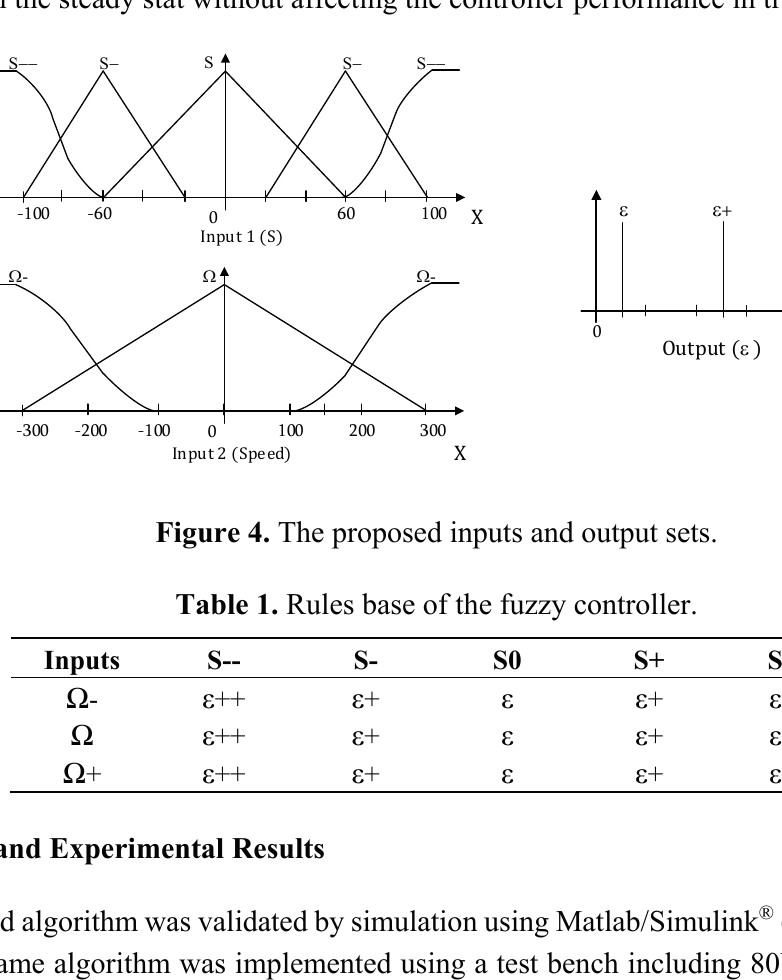
Figure 5. The machine parameters and PWM configuration requirement are presented in Table 2. To operate near nominal operating point, the PMSM was loaded by DC generator supplying a resistive